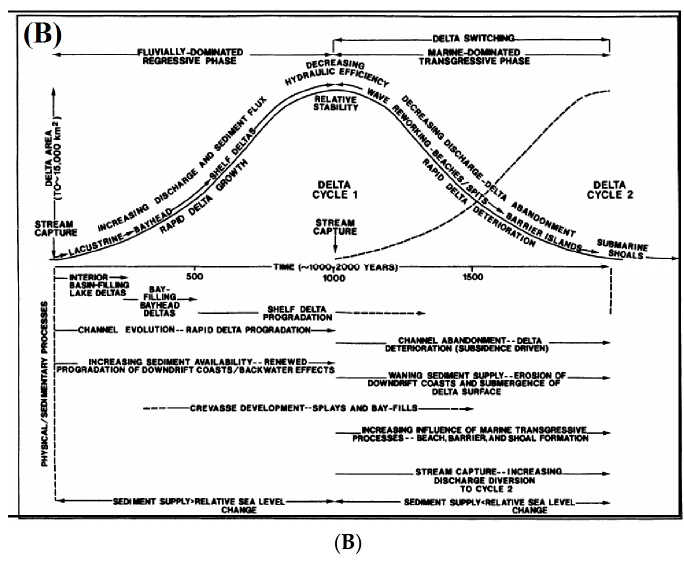
Figure 5. The Holocene Mississippi River delta cycle showing ( A ) spatial and temporal distribution of deltaic lobes [11]; and ( B ) overlapping temporal sequence of lobe building and abandonment [54], used by permission.